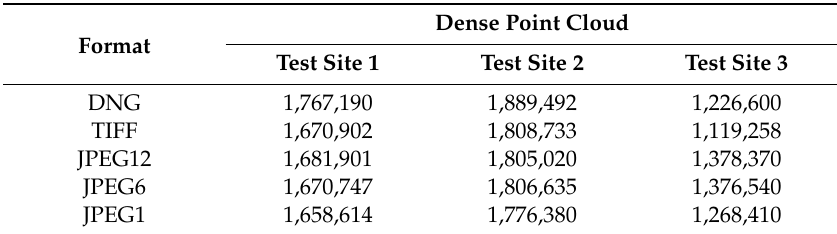
Table 9. Points of dense cloud in the several test sites.